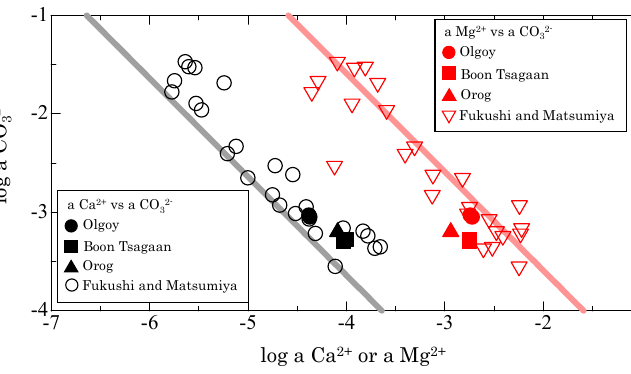
Figure 2. Relationship between the activity (log scale) of CO 3 2 − , and that of Ca 2 + (black symbols) or Mg 2 + (red symbols) in waters from Olgoy, Boon Tsagaan, and Orog Lakes and other alkaline lakes worldwide [13]. Straight black and red lines are the solubilities of MHC and AMC, as experimentally estimated by Fukushi and Matsumiya [13].